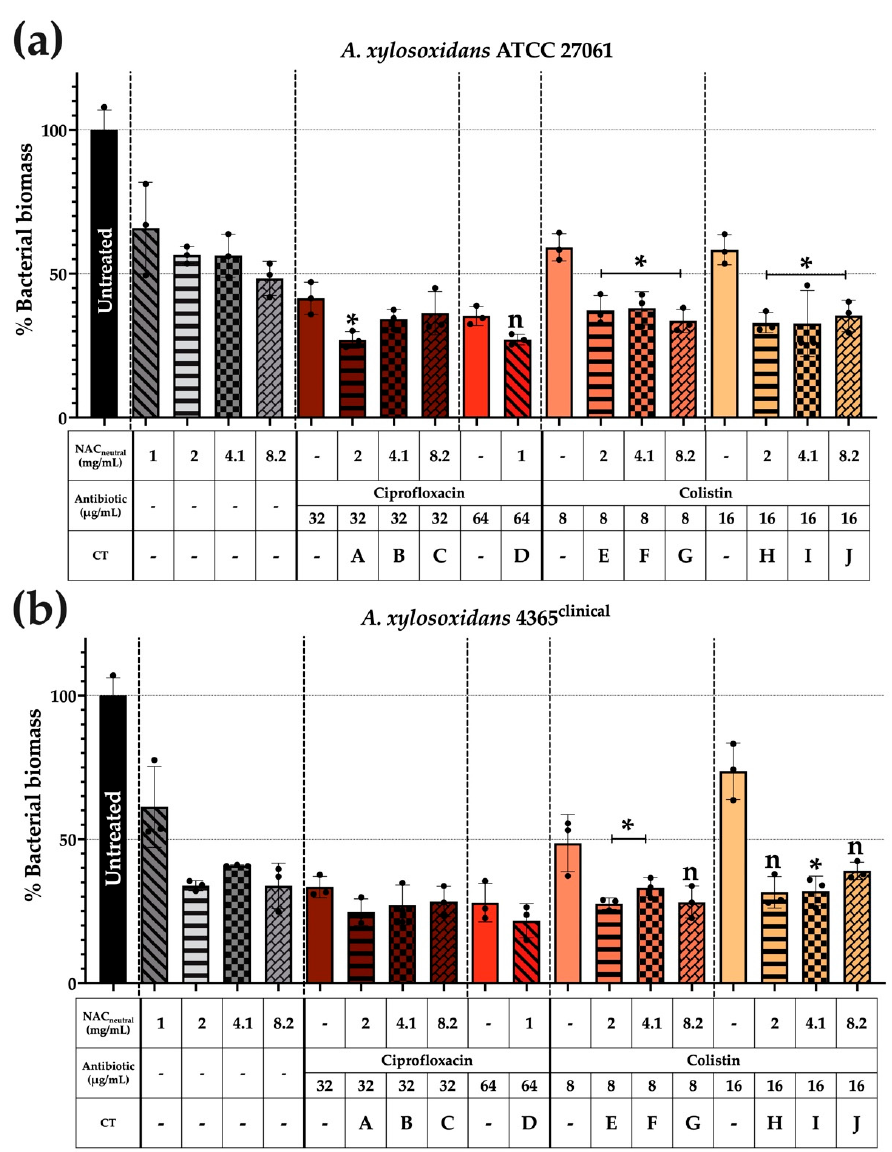
Figure 4. Mucin substrate-enhances A. xylosoxidans bacterial adhesion and reduced biomass occurred after a three-hour treatment challenge. Porcine mucin (Type IV)-coated plates were used to monitor bacterial adhesion and subsequent biofilm formation. Briefly, diluted bacterial cultures were added to mucin-coated wells at an OD 600 0.1 ± 0.02 for 48 h. Wells were washed with 1 × PBS. Treatments prepared in 1 × PBS were added for three hours. Wells were washed three times before heat fixing in a dry oven at 65 °C for one hour. Wells were stained with 0.1% ( w / v ) crystal violet for 24 h and de-stained with citrate buffer for one hour prior to absorbance being read at 595 nm. Biomass was quantified against a normalised, untreated control and displayed as “% biofilm biomass”. Strains shown are ( a ) ATCC 27061 and ( b ) AX 4365. (*) indicates the results are statistically significant ( p ≤ 0.05) (*) based on unpaired Student’s t -tests (with Welch’s correction). Significance was only displayed if CT was significant compared with untreated controls and both individual components of CT. Experiments were performed in biological triplicate (n =